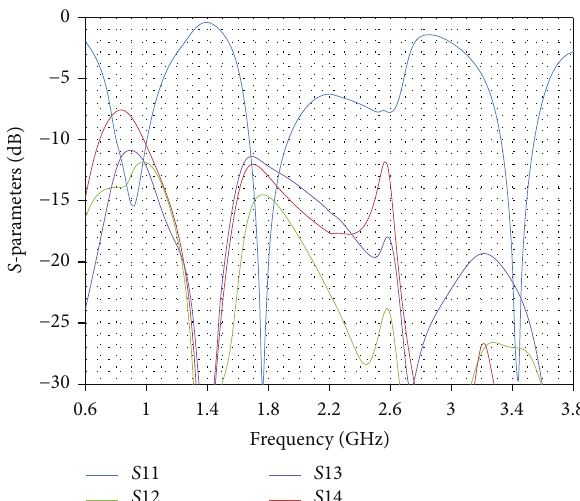
Figure 6: Parametric study on the influence of 𝐿5 .